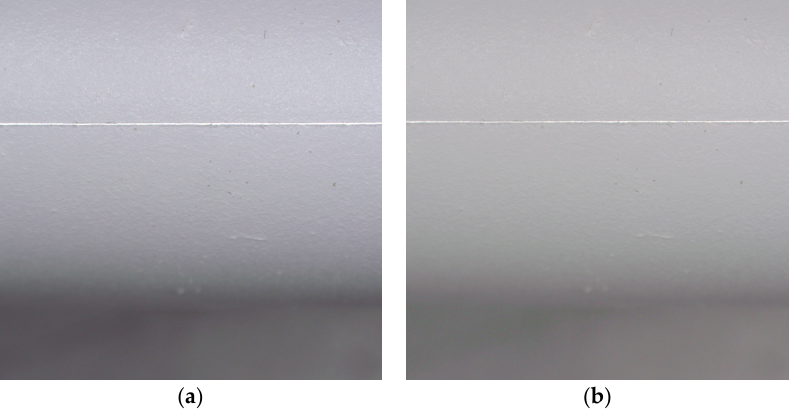
Figure 3. Results of a successful bending test. ( a ) adequate result achieved by P3 paint; ( b ) adequate result achieved by P9 paint. Table 9. Results of the visual inspection of the Erichsen test.